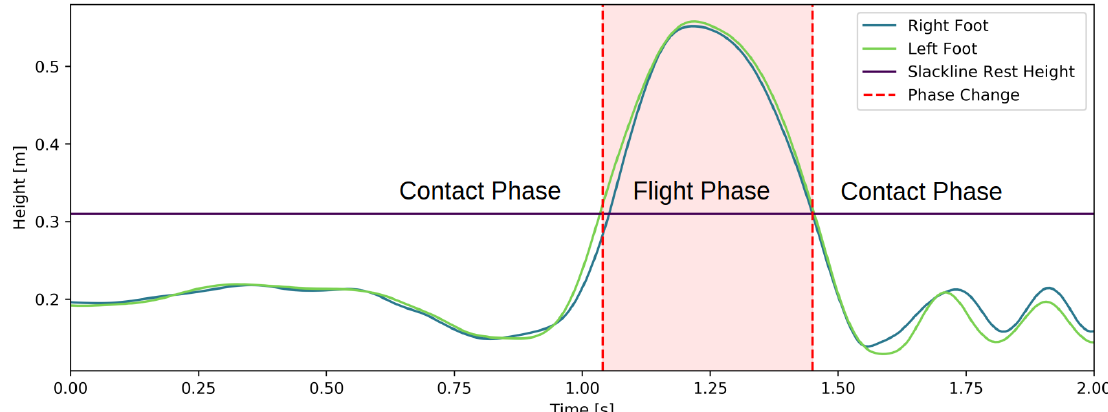
Figure 4. Feet positions are plotted against time. The rest height of the slackline is 31 cm. We determine the times of contact and flight phases when both feet are higher than the slackline. The flight phase is indicated in